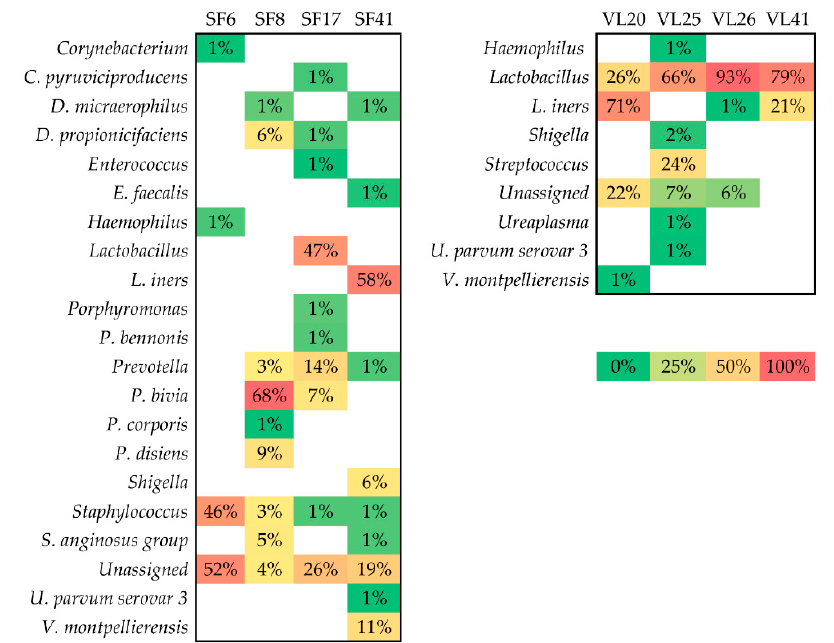
Figure 1. Microbial profile of HPV-positive seminal fluids (SF) and vaginal lavages (VL); the relative abundances of the bacteria identified in HPV-positive samples.